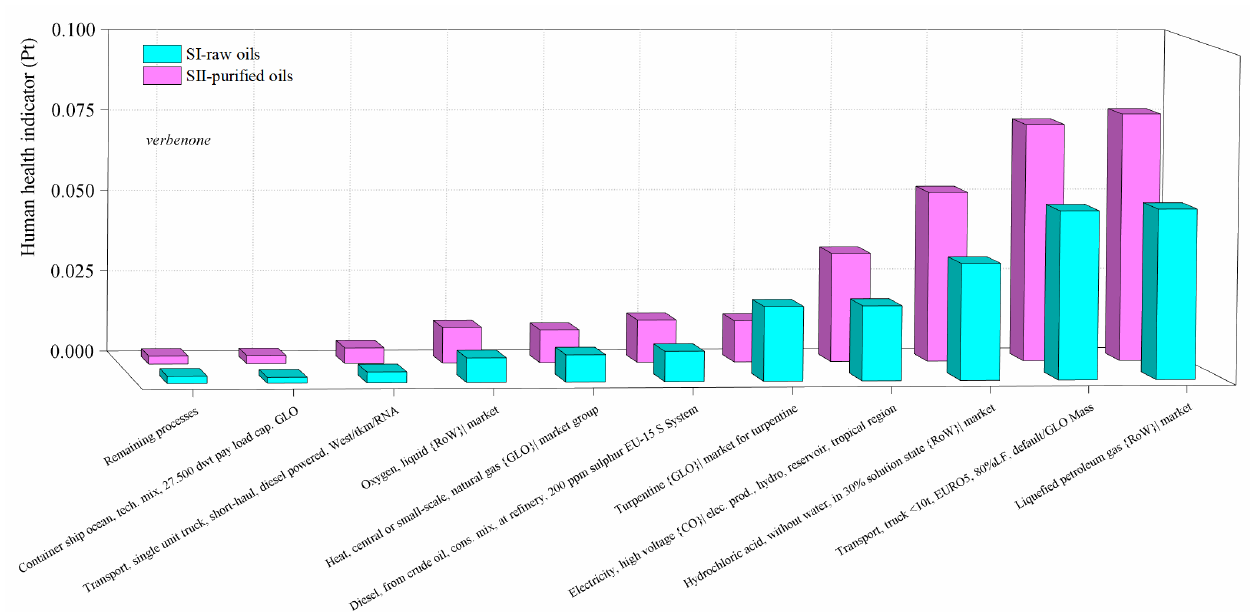
Figure 10. Comparison of the environmental impacts in the SI-raw-oils and SII-purified-oils scenarios for the verbenone process production by process contribution on the human health damage category. Assessment method: ReCiPe 2016 Endpoint (H) V1.04/World (2010) H/A.